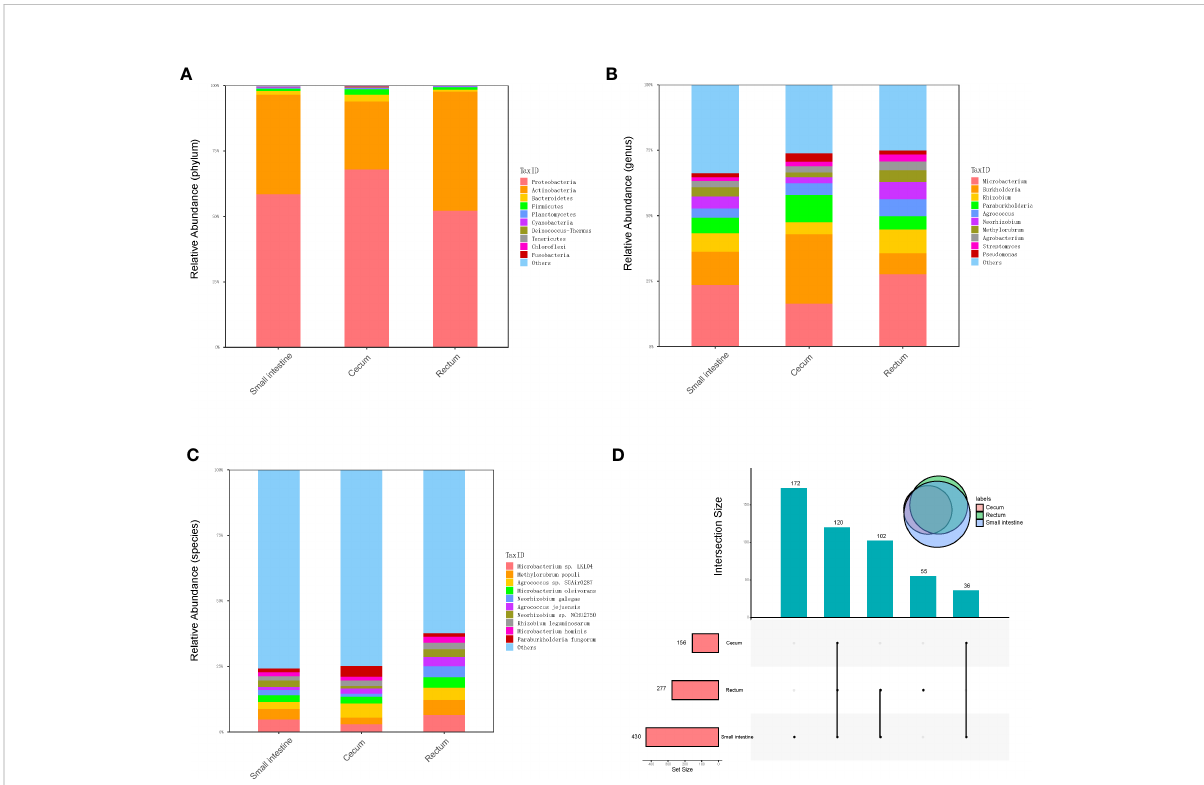
FIGURE 2 Metagenomics analysis of gut microbiota. (A) The top 10 abundant phyla in three different parts of fetal gut. (B) The top 10 abundant genera in three different parts of fetal gut. (C) The top 10 abundant species in three different parts of fetal gut. (D) Upset plot and venn plot of fetal gut microbiota in species level. The column above indicates the intersection of several samples in the row of which the point is